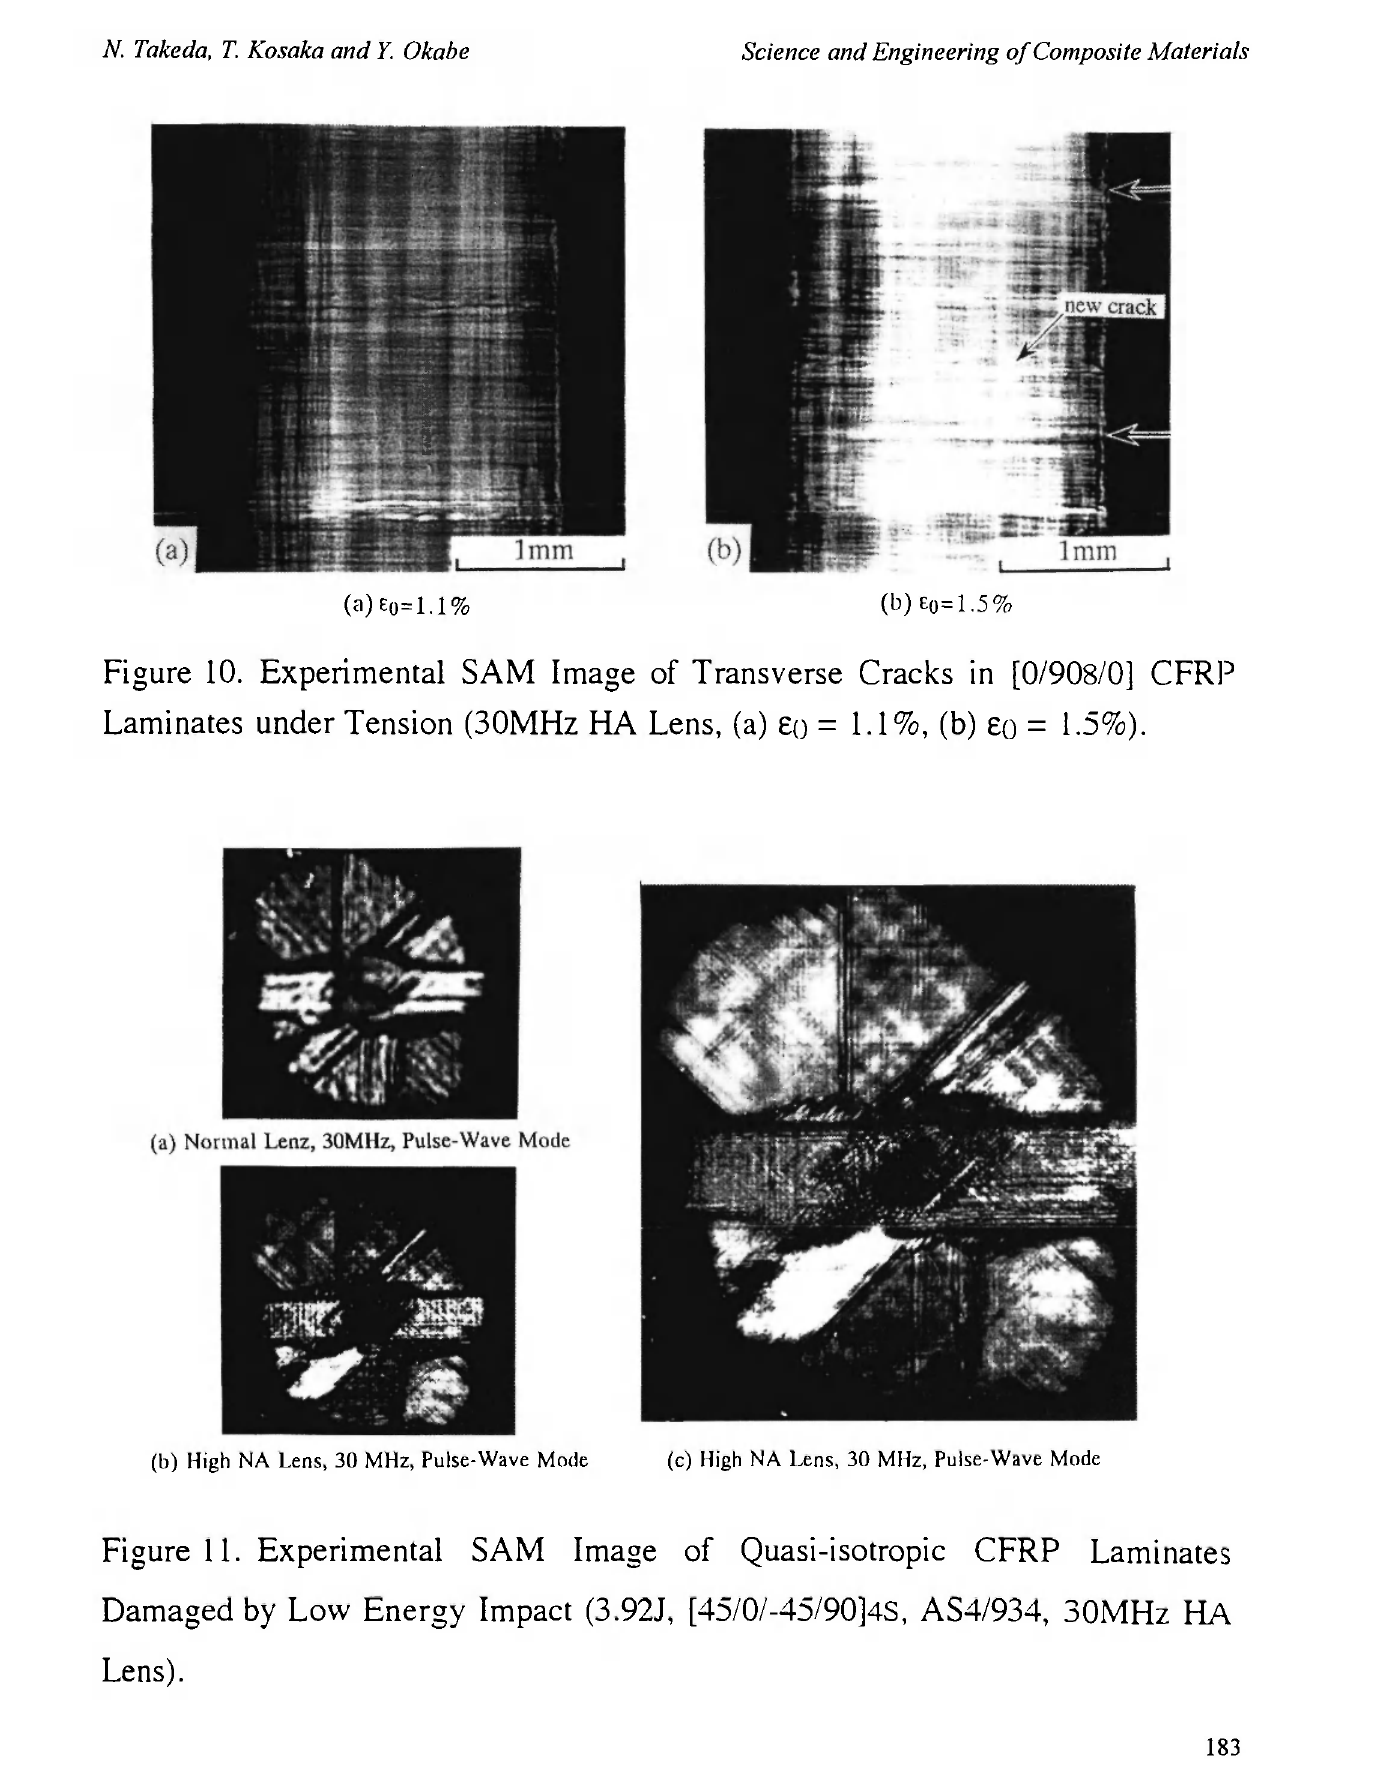
Figure 11. Experimental SAM Image of Quasi-isotropic CFRP Laminates Damaged by Low Energy Impact (3.92J, [45/0/-45/90]4S, AS4/934, 30MHz HA